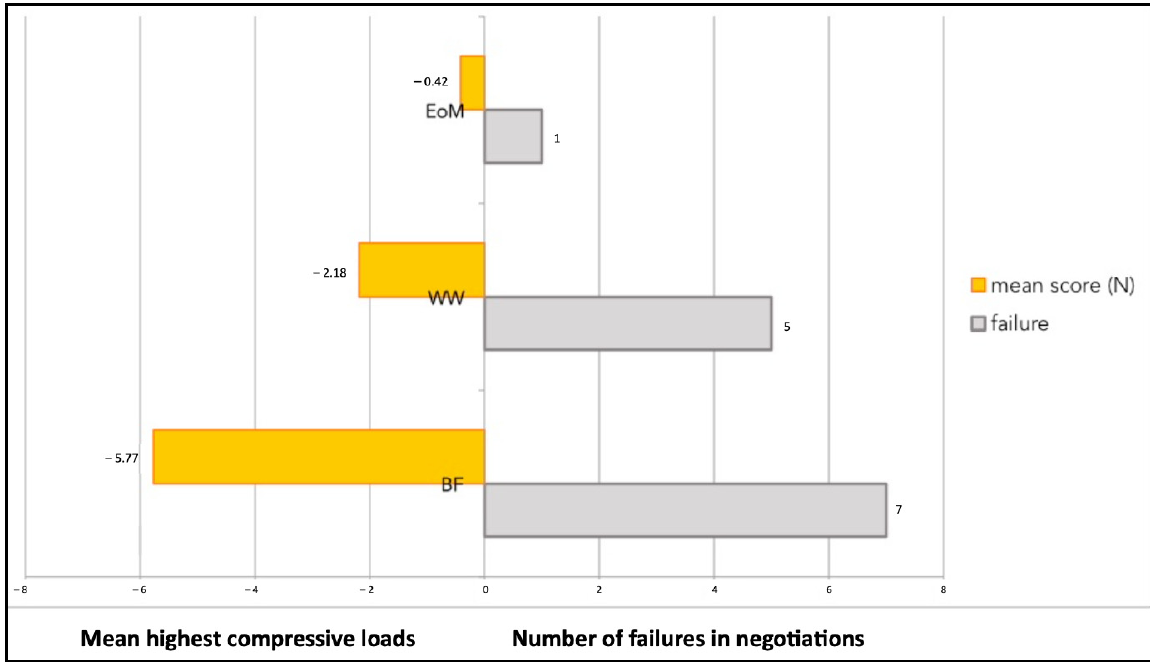
Figure 12. The mean highest compressive load values (newton, N) and the number of failures in negotiations of the balanced forces (BF) technique, watch winding (WW) motion, and the envelope of motion (EOM). On the y ‐ axis, the different techniques used are presented.